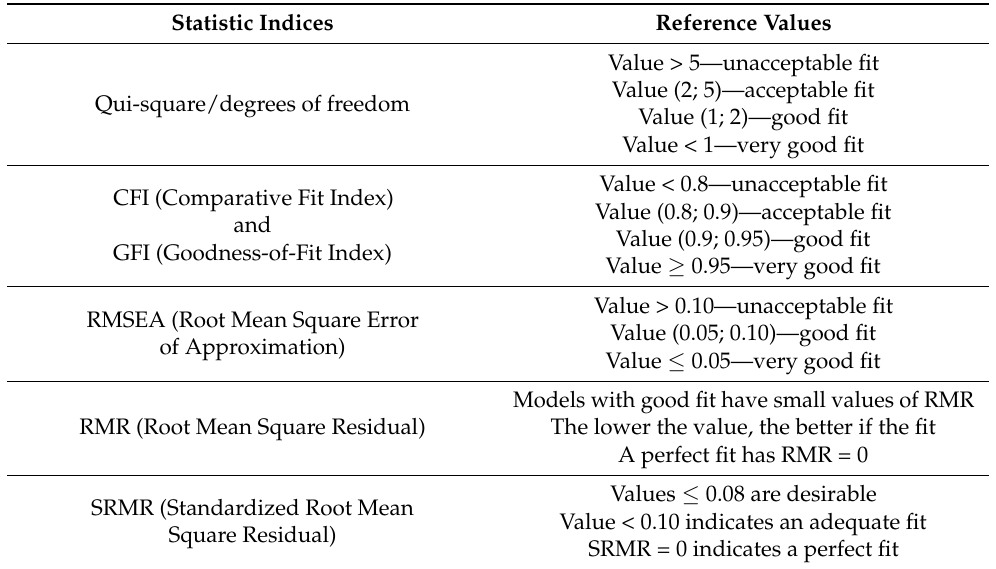
Table 1. Reference values of the quality indicators for the adjustment of the model [28,29]. Statistic Indices Reference